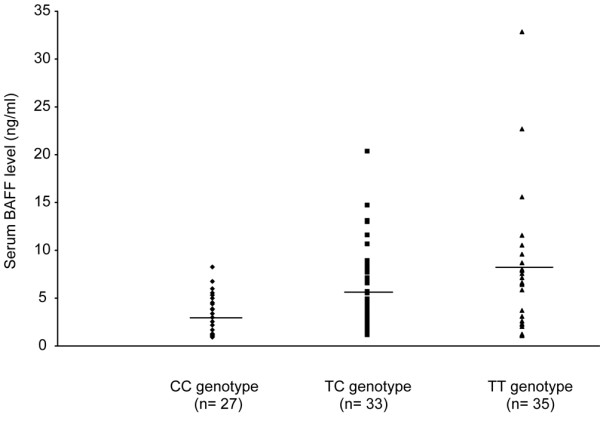
Association between BAFF -871 T/C polymorphism and serum BAFF level in 95 patients with pSS. Bars represent mean serum BAFF levels. BAFF = B-cell-activating factor; pSS, primary Sjögren's syndrome.